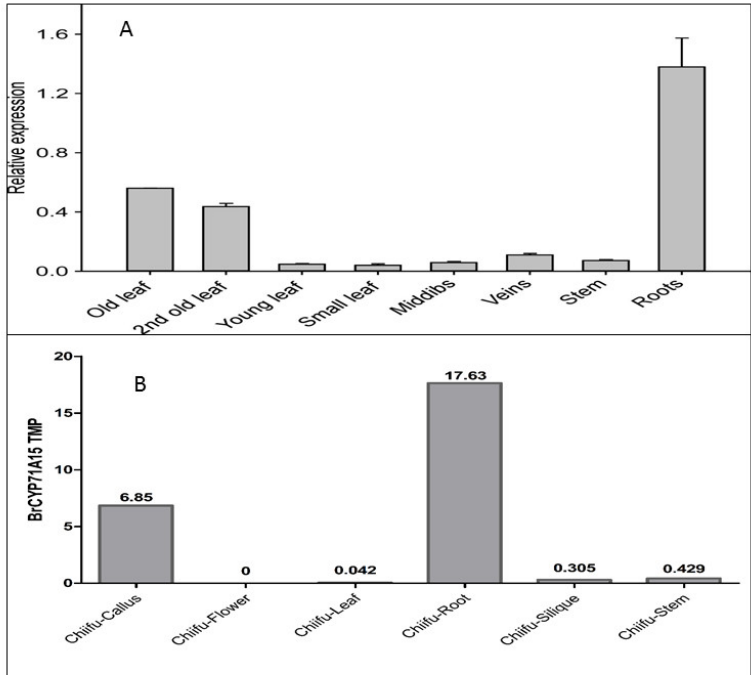
Figure 4. The expression of BrCYP71A15 in different tissues of Chinese cabbage ( A ), and TPM data ( B ) were download from Chinese cabbage database (http://brassicadb.cn/#/, accessed on 18 August 2022).